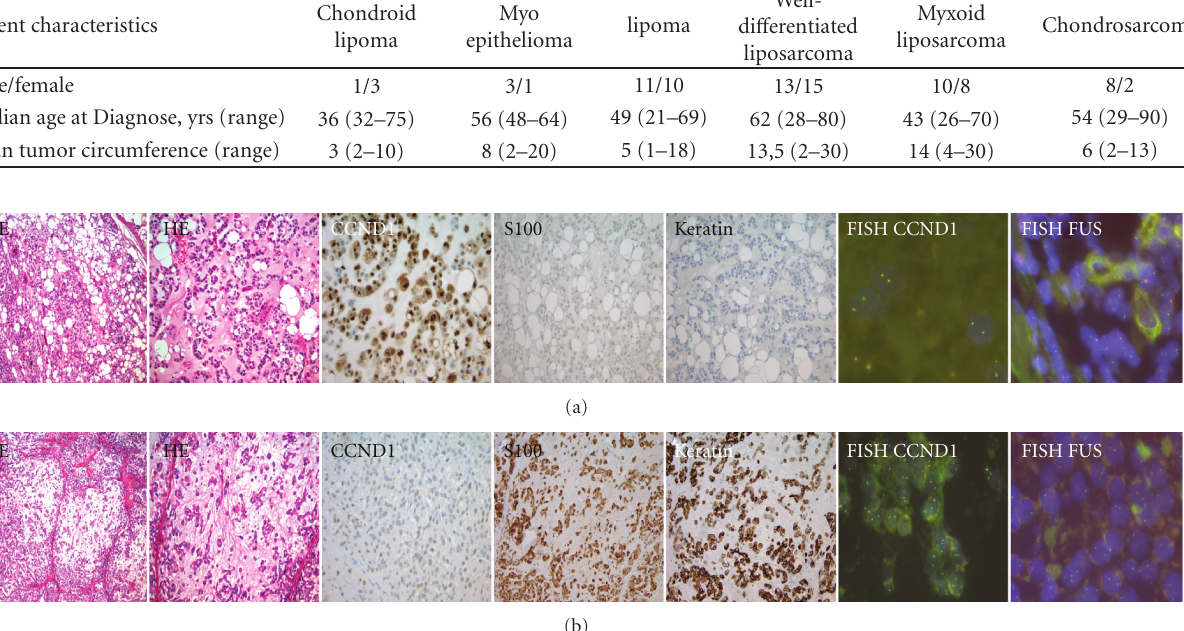
Figure 1: (a) Chondroid lipoma and (b)